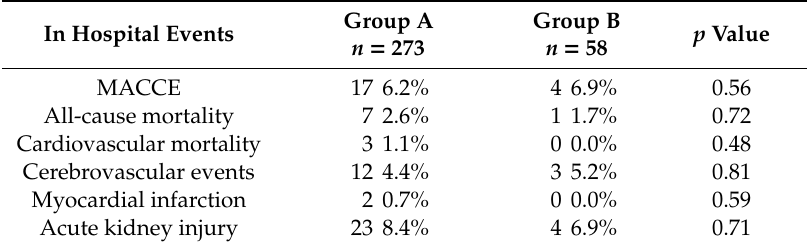
Table 6. In-hospital events of patients having undergone